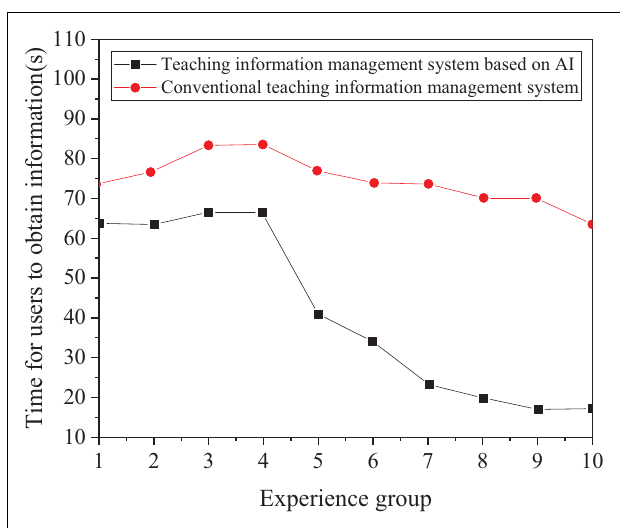
FIGURE 7 | System response delay test results.